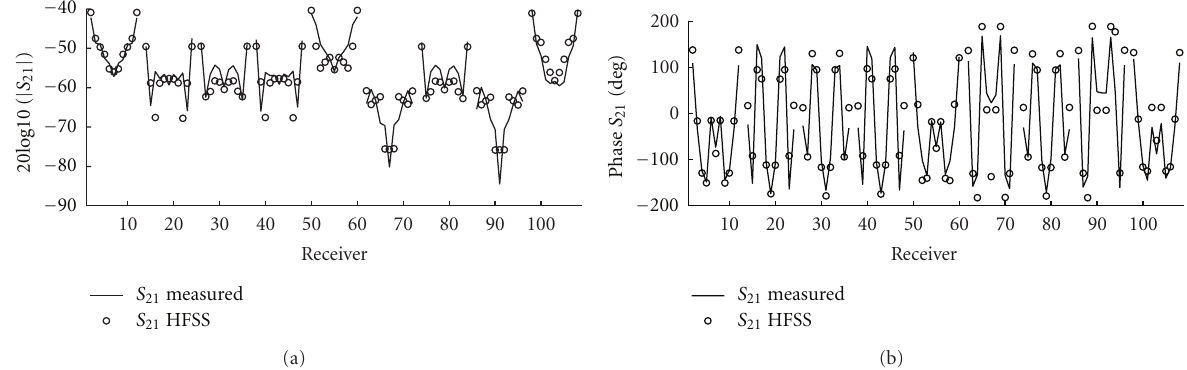
Figure 5: Measured and simulated magnitude and phase of incident S 21 between each of the three transmitting antennas and all receivers. Solid: measured. Dots: HFSS. The groupings from left to right are the eleven receivers of each level (middle, top, and bottom), repeated for the three transmitters (middle, top, and bottom), plotted counterclockwise when viewed from above for a given receiver level. For example, data 38: 48 are middle receivers and top transmitter. The magnitude and phase agree best for transmitters and receivers on the same level (i.e., data 1:11, 50 :60, and 98: 108).